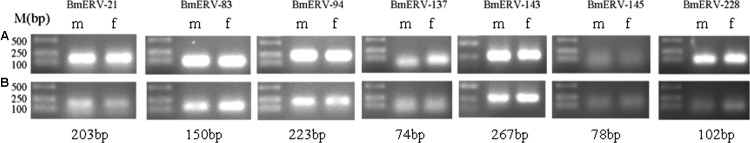
Integration and effective transcription of the BmERV env genes in the tissues of Bombyx mori. (A) PCR with DNA templates was used to verify the presence of env genes in the silkworm genome. Tissues samples of DaZao were extracted from midguts (m) and fat bodies (f). (B) RT-PCR was employed to detect the expression of the env genes of BmERV-21, BmERV-83, BmERV-94, BmERV-137, BmERV-143, BmERV-145, and BmERV-228 using cDNA templates.